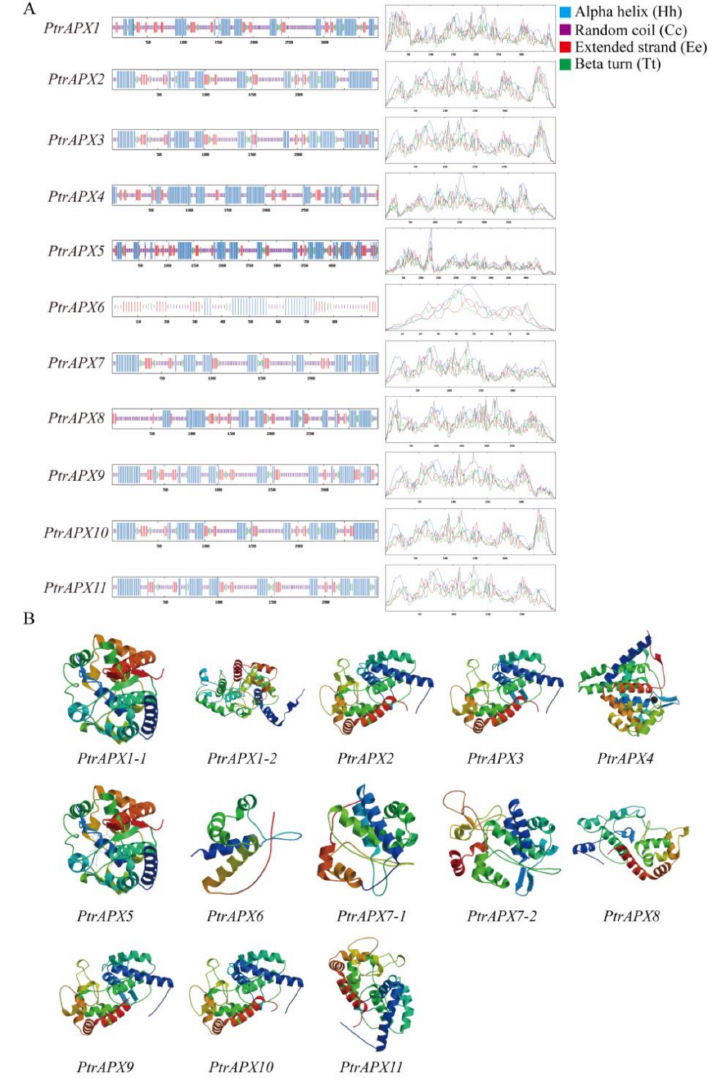
Figure 5. Secondary and tertiary structures of PtrAPX proteins. ( A ) Secondary structure of PtrAPX proteins. Motifs are represented by different colors: blue, α -helix; purple, random coil; red, extended strand; green, β -turn. ( B ) Tertiary structure of PtrAPX